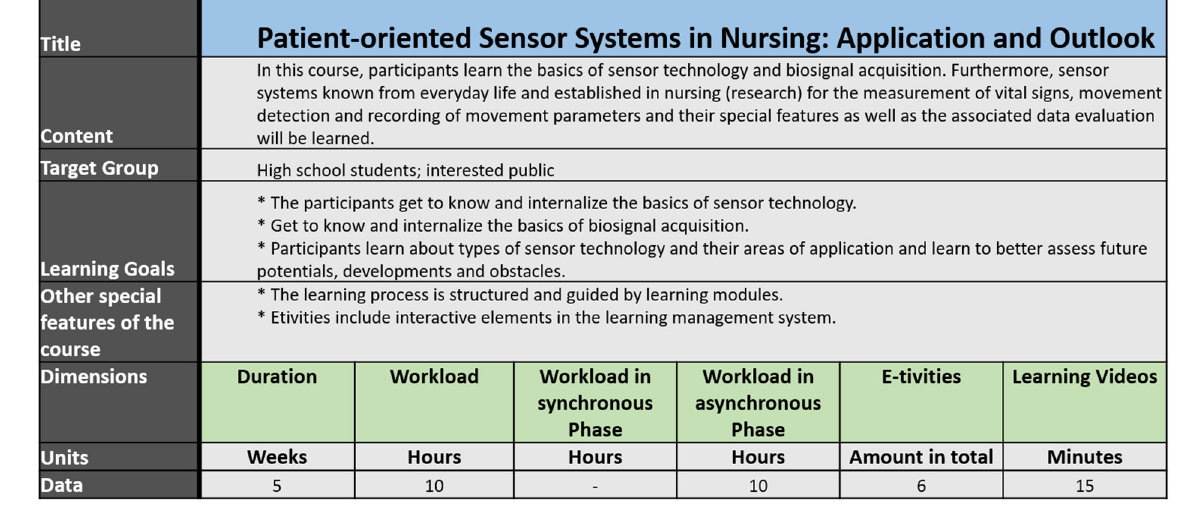
Figure 5. Course properties for ZLG-TP2 Course: “Patient-oriented Sensor Systems in Nursing: Application and Outlook”.